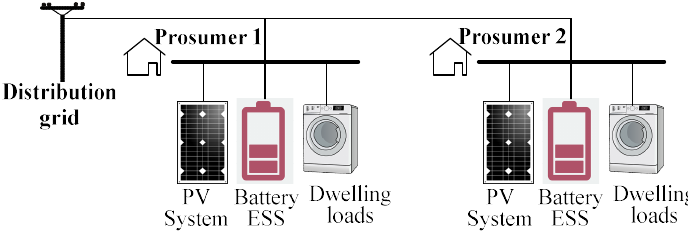
Figure 5. Schematic of the demand and energy resources of each prosumer in the nanogrid under study.